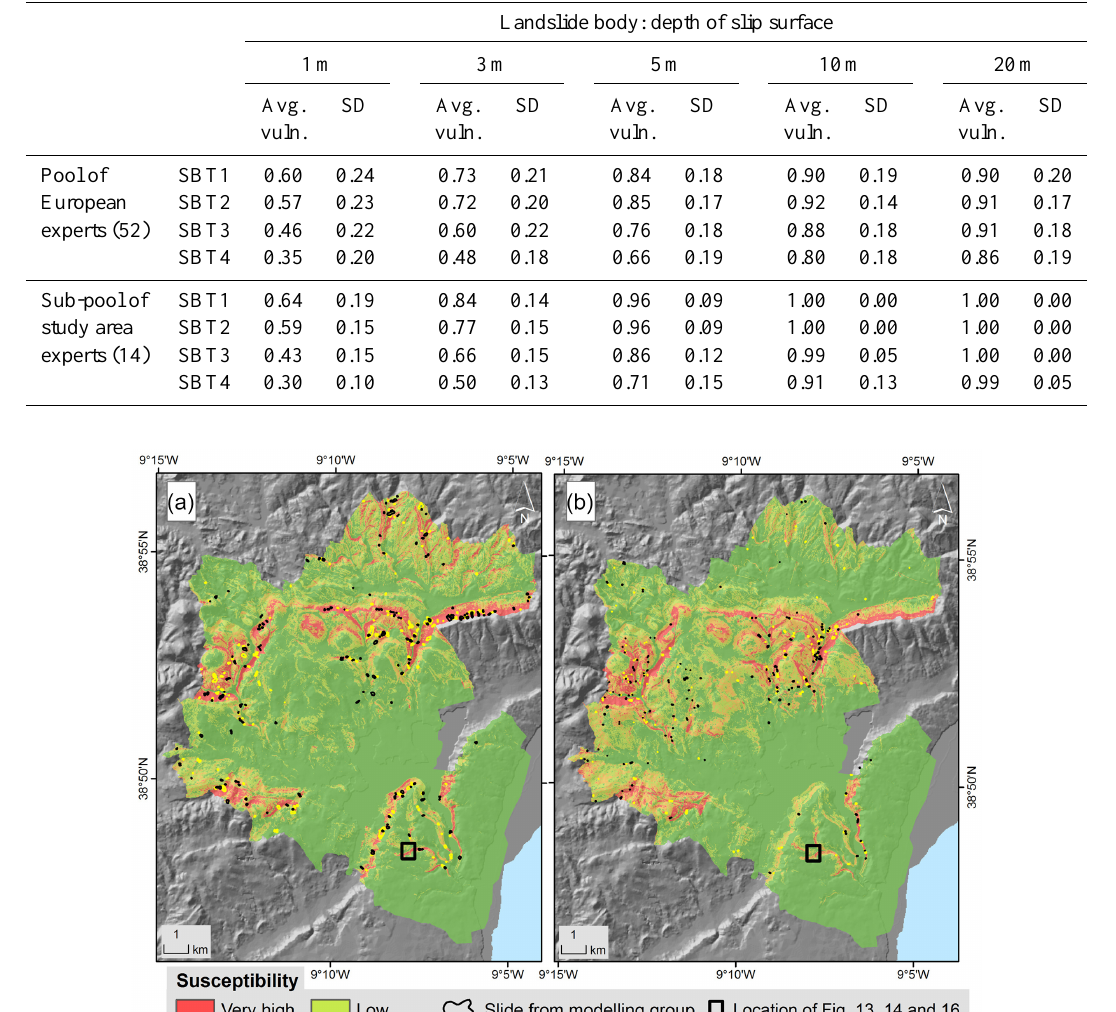
Table 7. Average vulnerability (Avg. vuln.) and standard deviation (SD) for each structural building type located on a landslide body (cf. Ta- ble 1 for building type).